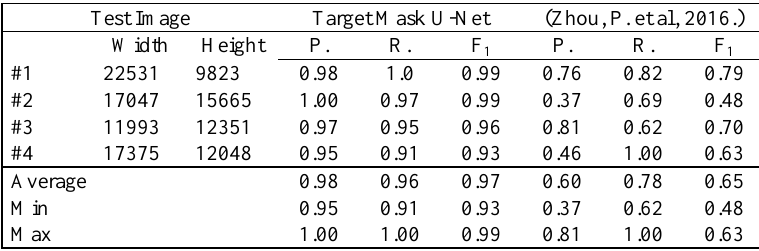
Table 2. Numerical results of proposed method and Zhou’s method (P. means precision, R. means